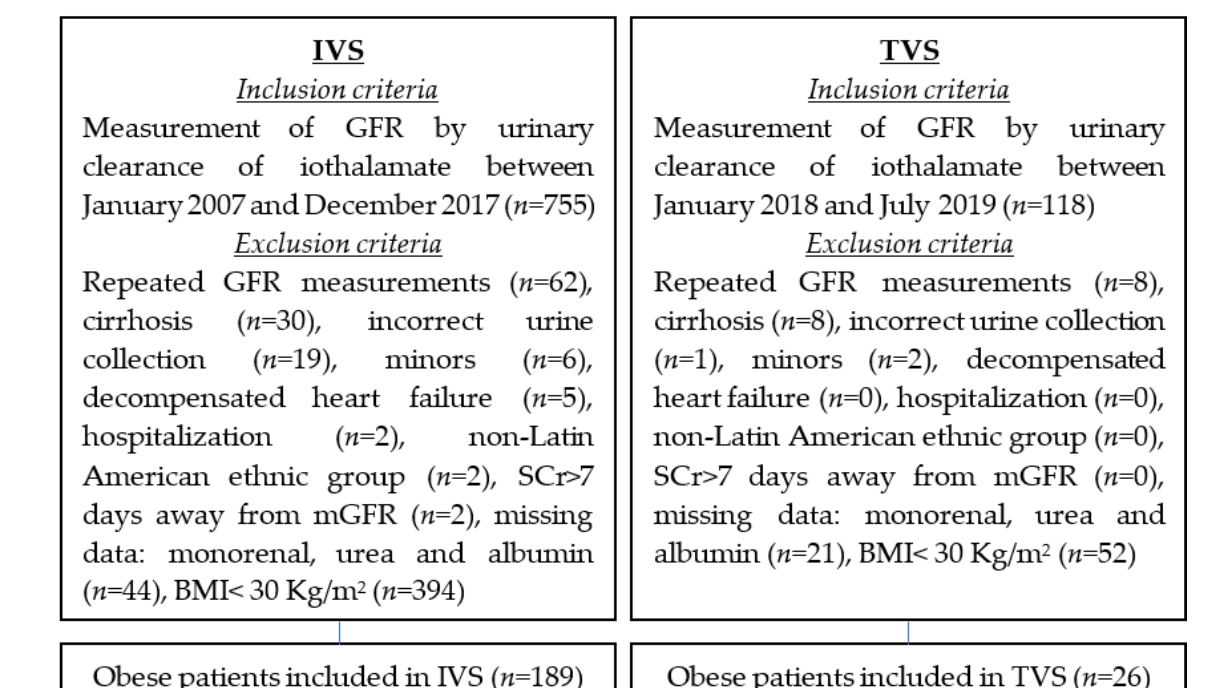
Figure 1. Flowchart with the inclusion and exclusion criteria in the internal validation sample (IVS) and in the temporary validation sample (TVS).